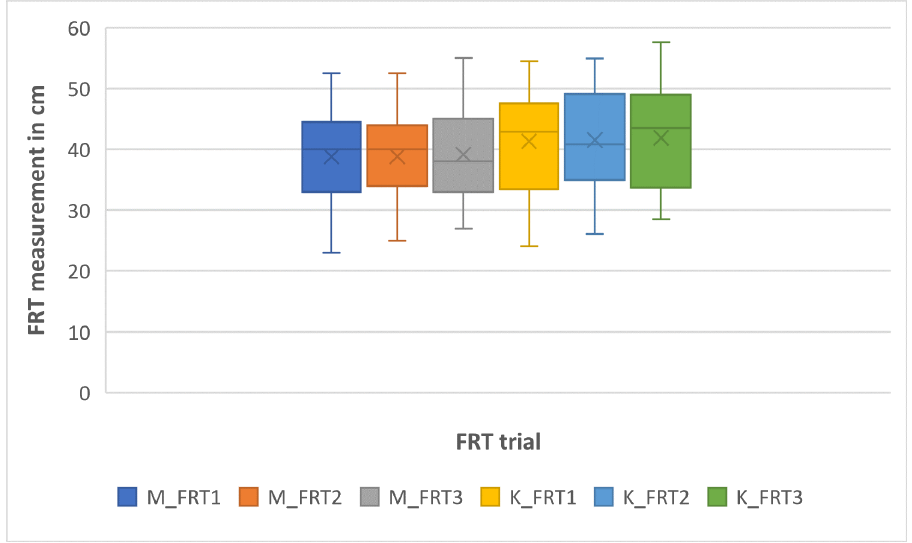
Figure 7. Box plot of the FRT measurements by the experimental system (K_FRT) and manually (M_FRT) in Experiment